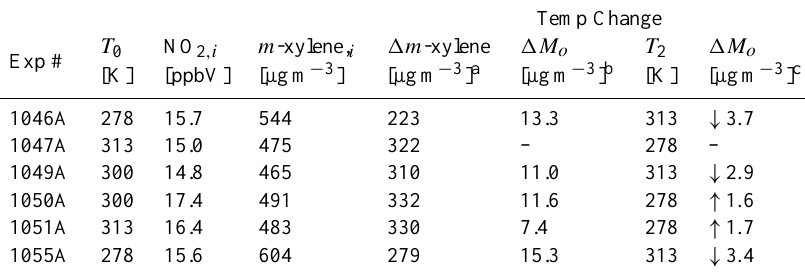
Table 1. Experimental conditions and results summary for the m -xylene photooxidation reactions.